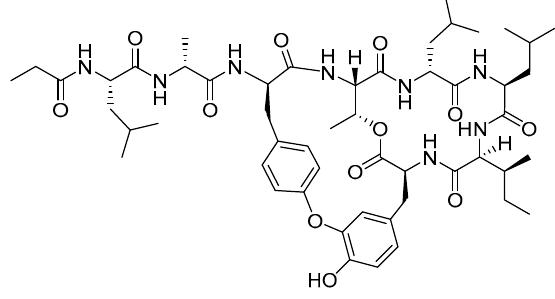
Figure 1. Chemical structure of seongsanamide A.